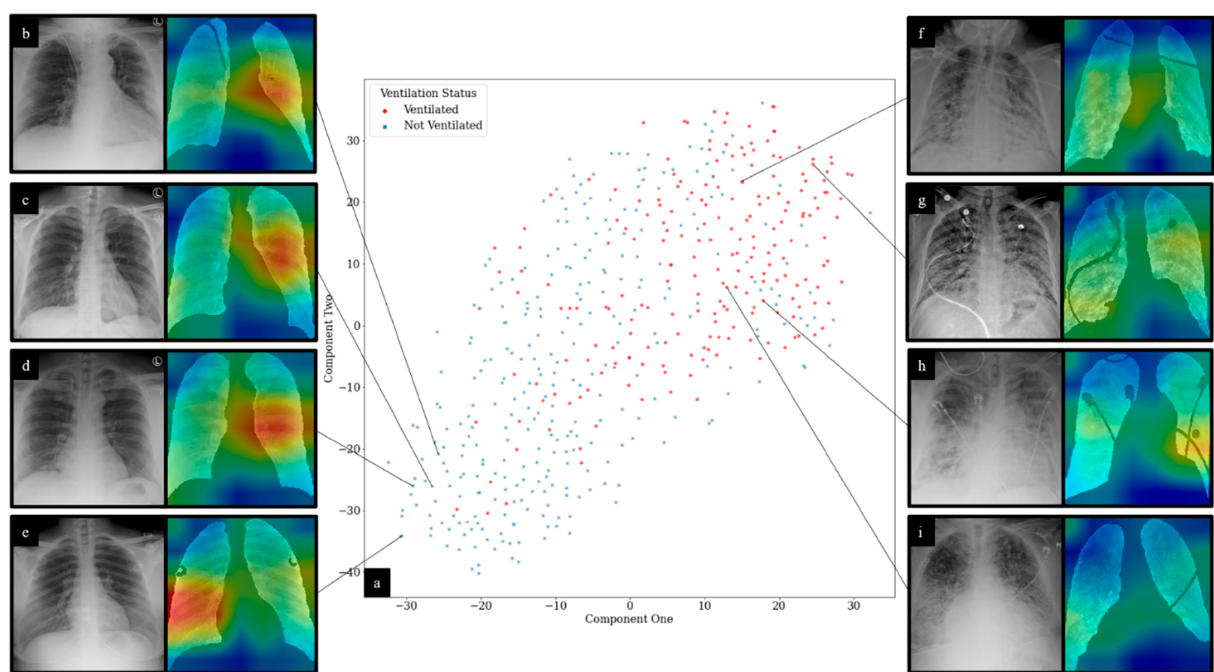
Figure 9. t-SNE and CAM visualization of DL predictions: ( a ) displays t-SNE clustering of DL network outputs for ventilation prediction; ( b – d ) demonstrate no focal consolidation or infiltrates. CAMs show maximal signal intensity in the left middle lung zone predominantly along the perihilar region; ( e ) shows no focal consolidation or infiltrates. CAM shows maximal signal intensity in the right mid to lower lung zone; ( f ) demonstrates diffuse patchy infiltrates bilaterally, predominantly in the mid to lower lung zones. CAM shows the highest signal intensities in the right mid to lower lung zones in areas of dense infiltrates. Additionally, noted is slightly increased CAM activity in the left lower lobe around the areas of dense infiltrates; ( g ) demonstrates diffuse patchy infiltrates bilaterally. CAM shows the highest signal intensities in the right lower and left upper lung zones around areas of slightly dense infiltrates; ( h ) shows diffuse infiltrates bilaterally with relative sparing of the right upper lobe. CAM shows the highest signal intensities in the right mid and left mid to lower lung zones in areas of dense infiltrates; ( i ) demonstrates diffuse bilateral reticular opacities with interlobular septal thickening along with superimposed dense infiltrates predominantly in the lower lobes. CAM shows the highest signal intensity in the right lower lung zone around areas of dense infiltrates. CXR interpretation performed by J.G. (15 years of experience).